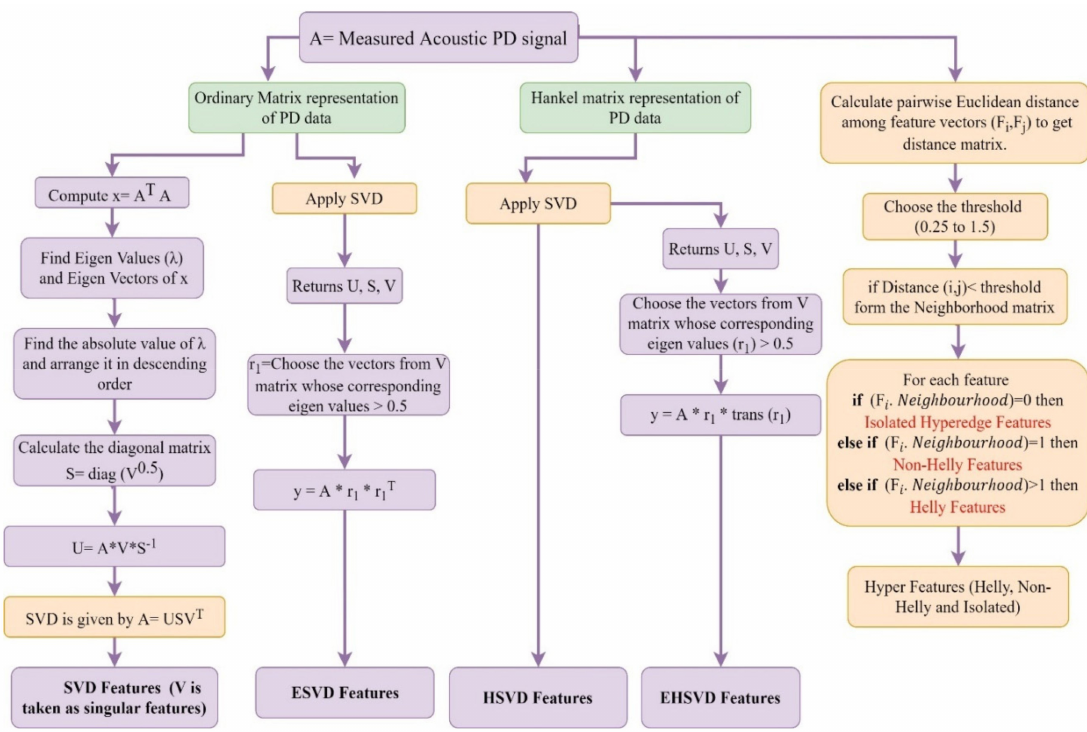
Figure 7. Flowchart of singular feature and hyper feature extraction from acoustic PD